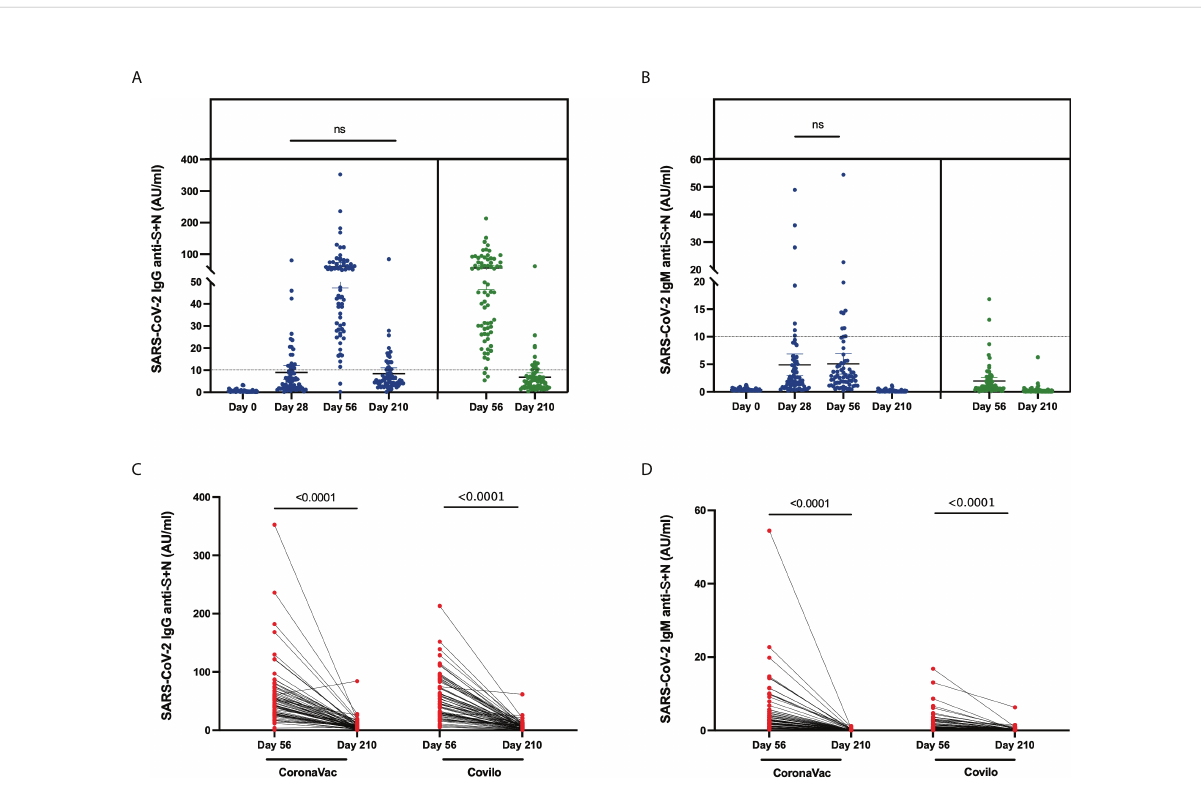
FIGURE 3 Anti-SARS-CoV-2-speci fi c IgG and IgM levels induced by inactivated COVID-19 vaccines. (A, B) Levels of anti-SARS-CoV-2-speci fi c IgG (A) and IgM (B) in serum samples from CoronaVac-vaccinated participants collected on Day 0, Day 28, Day 56, Day 210 and from Covilo-vaccinated participants on Day 56 and Day 210. (C, D) Dynamic changes in anti-SARS-CoV-2-speci fi c IgG (C) and IgM (D) levels between 28 days (Day 56) and 6 months (Day 210) after the second vaccine dose. ns: no signi fi cance,